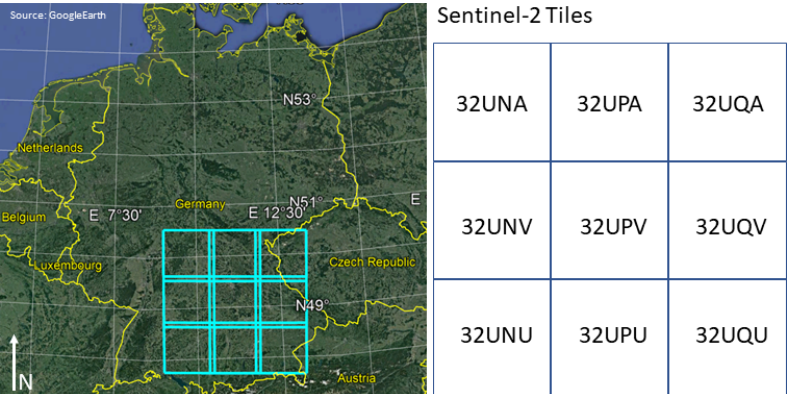
Figure 2. Themid-European test site highlighted in cyan covers large parts of the German federal state of Bavaria, Western parts of the Czech Republic and small parts of Austria.